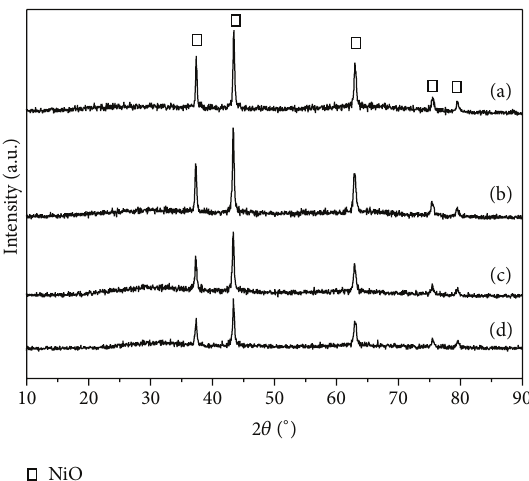
Figure 2: XRD profiles for the catalysts calcined at 500 ∘ C for 3 h. (a) 15Ni/100Al 2 O 3 , (b) 15Ni/10CaO90Al 2 O 3 , (c) 15Ni/20CaO80Al 2 O 3 , and (d) 15Ni/30CaO70Al 2 O 3 .